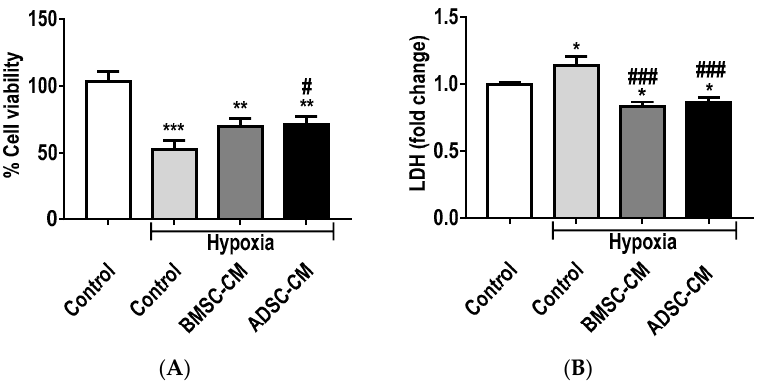
Figure 2. ( A ) Cell viability and ( B ) LDH release of primary rat AECs treated with human MSC-CM during hypoxic (1.5% O 2 ) exposure for 24 h. The viability and LDH release of primary AECs were measured via MTT and LDH assays, respectively. Data presented as mean ± SD; n = 3 (* p < 0.05, ** p < 0.01, *** p < 0.001 vs. normoxia control, # p < 0.05 and ### p < 0.001 vs. hypoxia control). The resulting data were statistically analysed using one-way ANOVA and Tukey’s multiple comparison test.